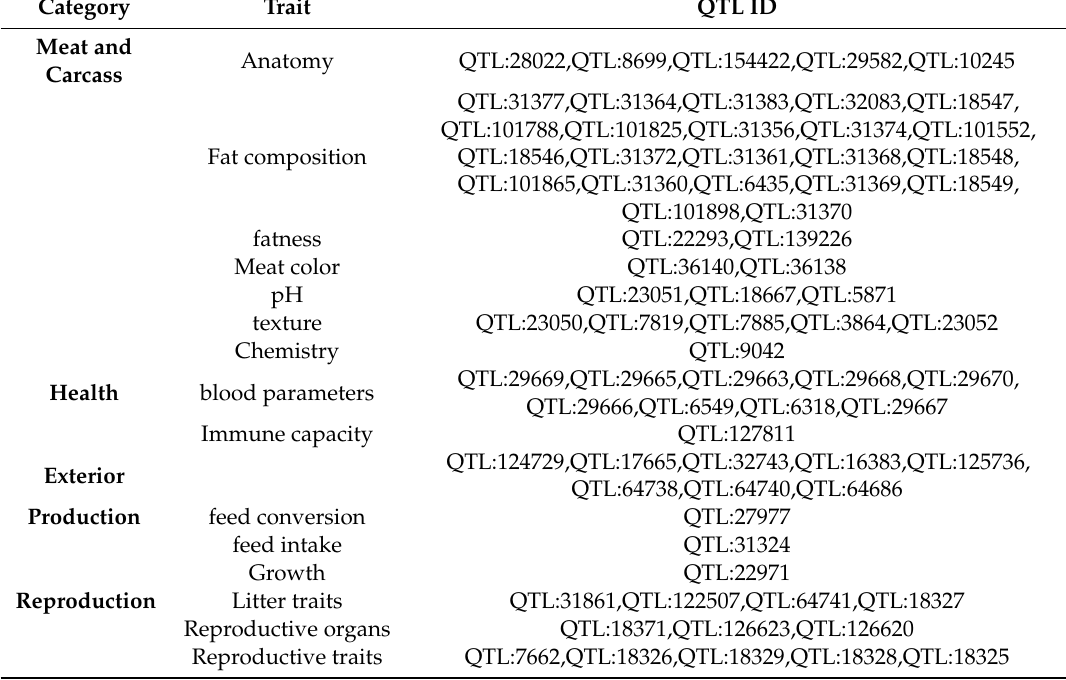
Table 2. A list of quantitative trait locus overlapping with the core runs of homozygosity (ROH) regions in Pi é train pig.